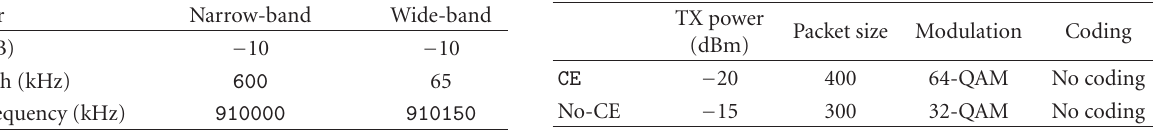
Table 4: Interference environments.